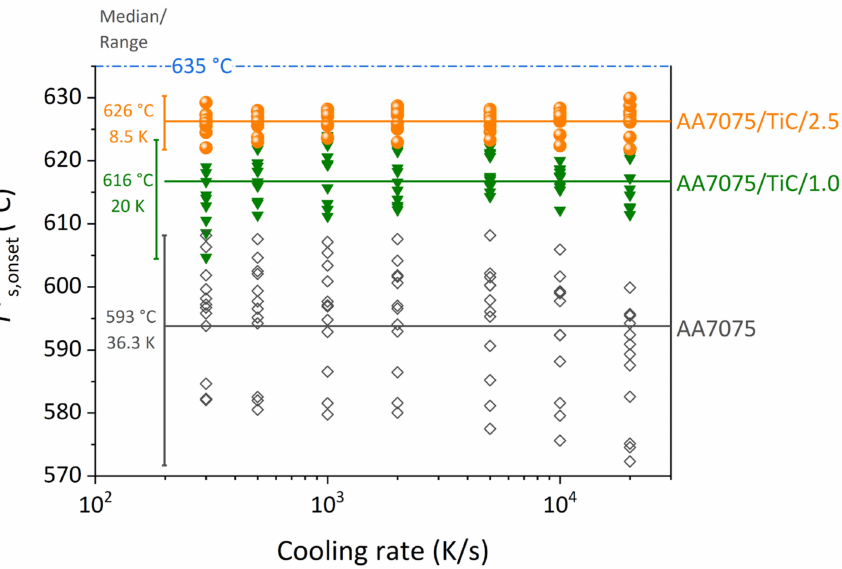
Figure 4. Solidification onset temperatures from DFSC for different powder variants as a function of the cooling rate in the range of 100 K/s–20,000